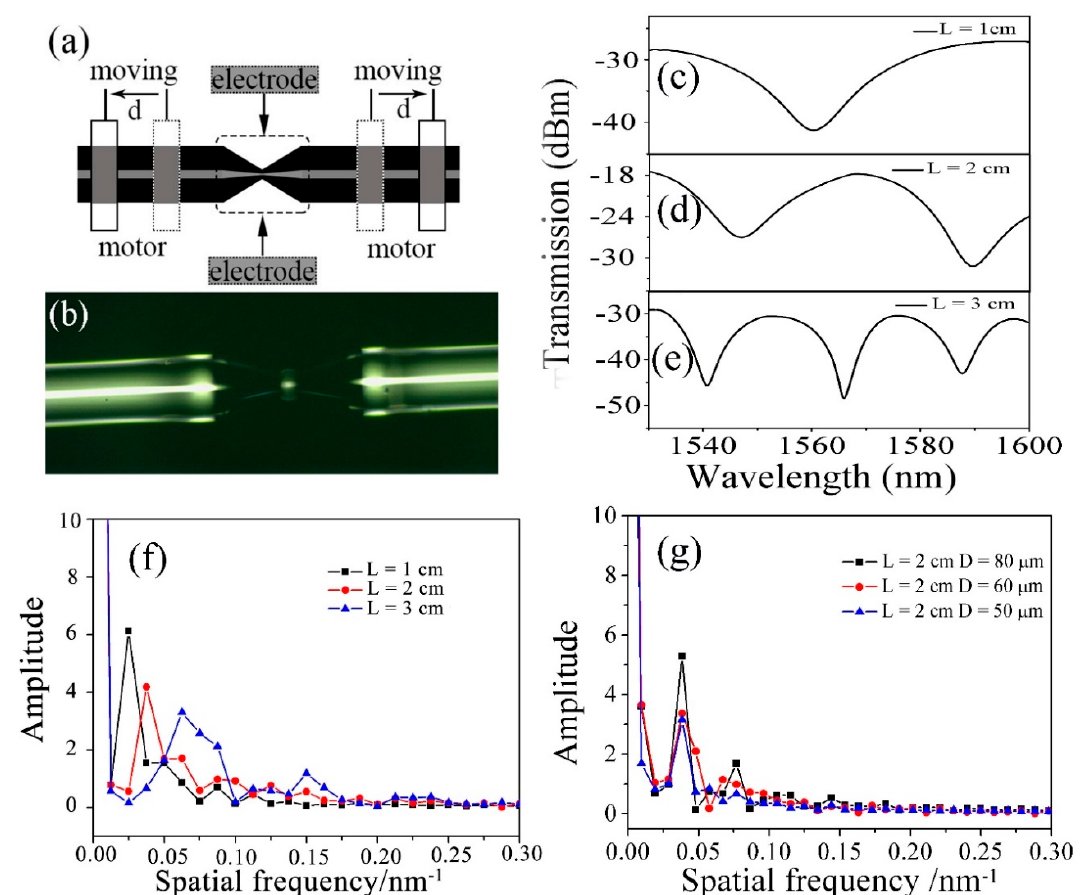
Figure 3. ( a ) Schematic diagram of the micro taper structure fabrication process; ( b ) the photo under microscope; ( c – e ) the spectral responses with a sandwiched single mode fiber (SMF) length of 1, 2, and 3 cm, respectively; ( f ) the fast Fourier transform (FFT) spatial frequency spectra with arm lengths of 1, 2, and 3 cm, respectively. ( g ) The FFT spatial frequency spectra with waist diameters of 50, 60, and 80 µ m, respectively.